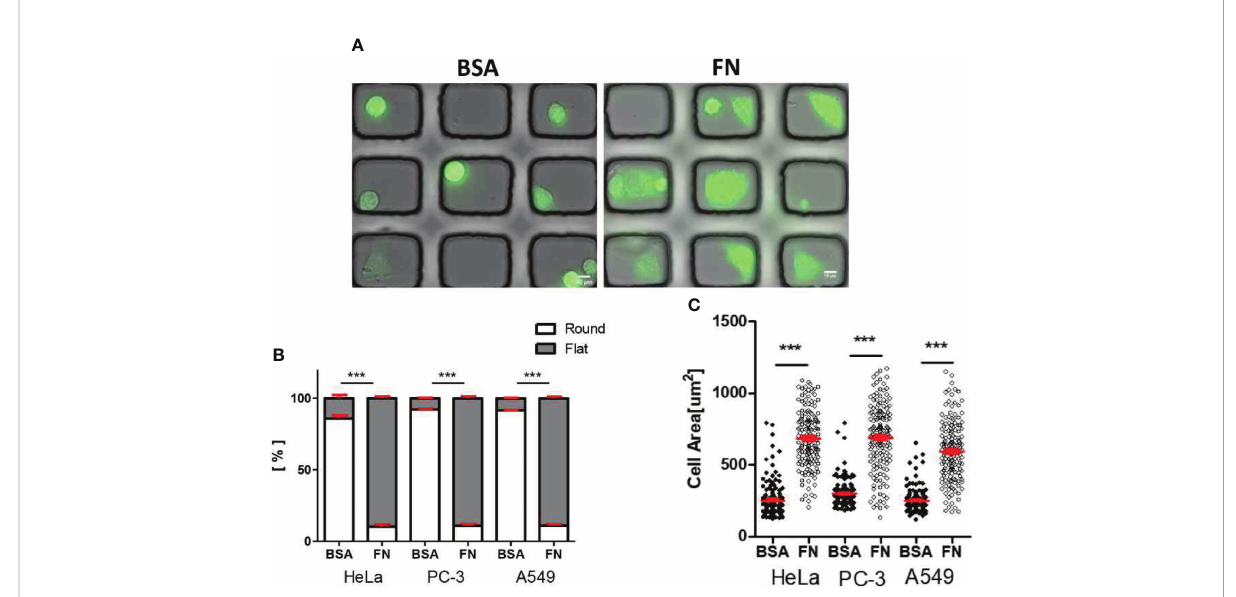
FIGURE 3 Morphology of solid tumor cells in BSA-coated and FN-coated microwells. (A) DIC/ fl uorescence overlay images of HeLa cells (green) loaded in microwell arrays (microwell Size: 50 m m x 45 m m) either coated with BSA (left) or FN (right). Scale bars: 10 m m. (B, C) Effects of microwell coating on morphology (B) and cell area (C) of various solid tumor cells. Mann-Whitney test was used, *** <